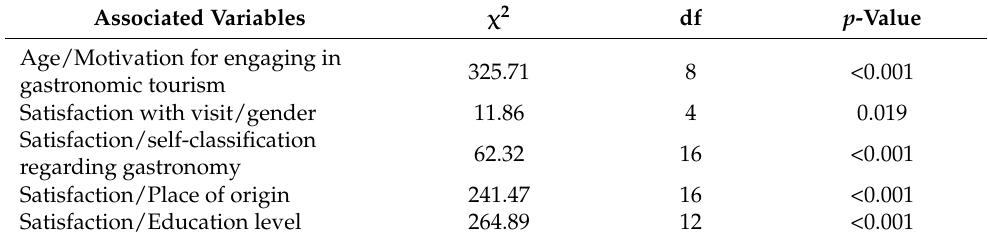
Table 6. Bivariate analysis.